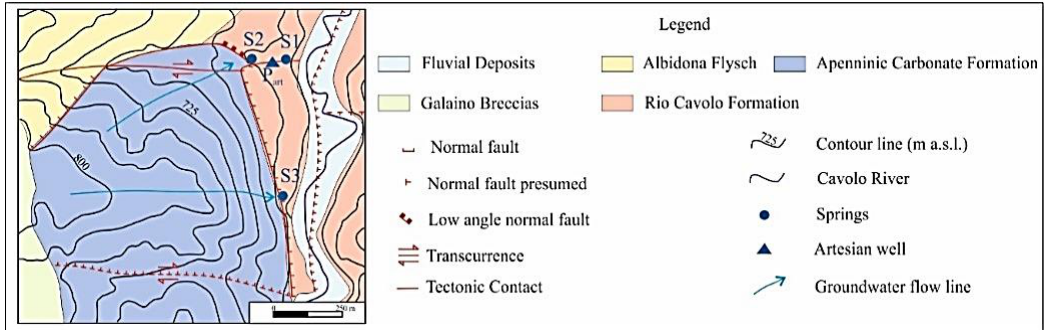
Figure 4. Geological map of the study area; the blue points and the triangle show the location of the investigated springs S1, S2, and S3 and the artesian well P art (the geological sketch is taken from Olita 2018, modified [33]).